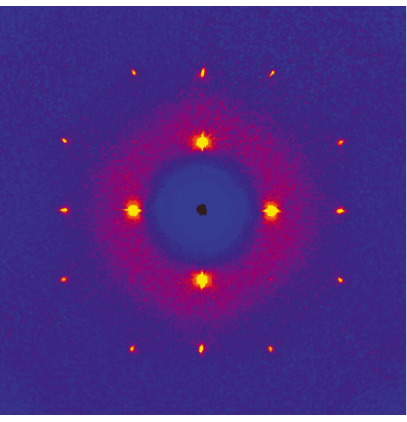
Figure 1 The ( hk 0) layer of reciprocal space for the plastic phase of cyclohexane, at 255 K. Direction [100] runs on the right, direction [010] runs upward.